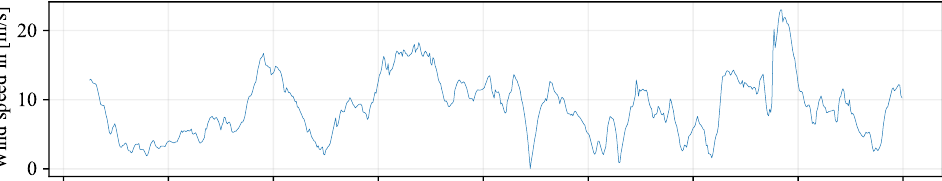
Figure 4. Generated power of different wind farms from 1 January 2019 to 31 December 2019.